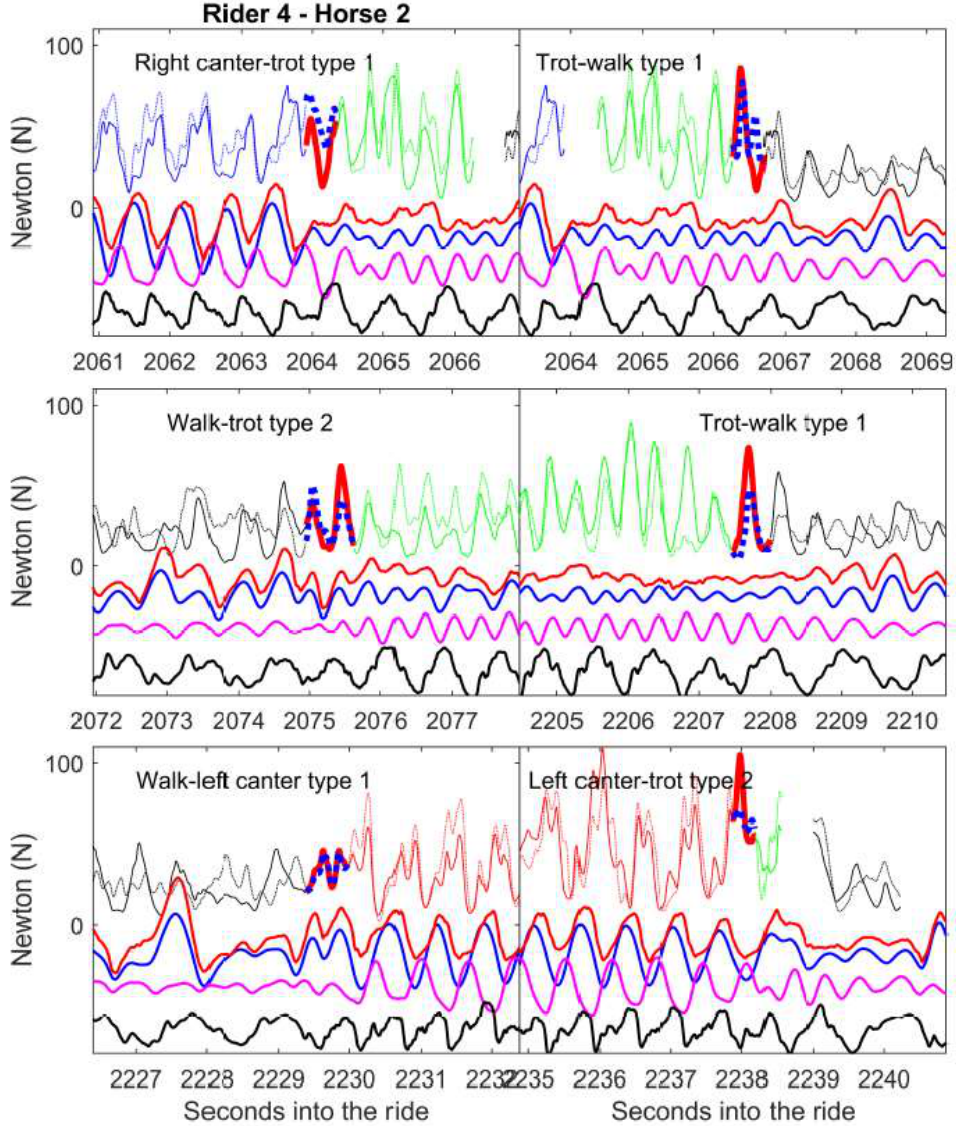
Figure 1. Examples of rein tension signals during six successive transitions in one horse. On each graph the upper curves show left and right rein tension (N) before, during and after the transition (horse 2 / rider 4). The left rein is solid and the right dotted. The bolded part represents the actual transition (red / blue left / right rein). Black represents walk, green is trot and red / blue are left and right canter. Only one transition is featured per panel and rein data gaps represent other transitions, halts or unidentified gaits. The curves in the lower part of the graphs are dimensionless traces for the poll (blue) and croup (magenta) heights, croup roll (black, positive values represent downward motion of the left hip) and nose angle (red, positive forwards / nose out).